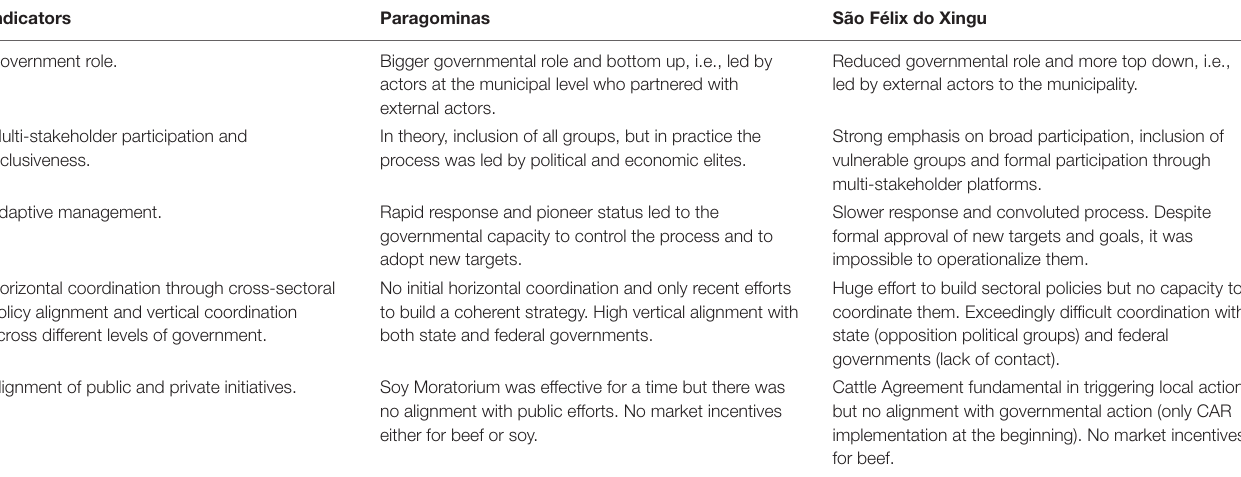
TABLE 4 | Summary table comparing cases across the five indicators. Indicators Government